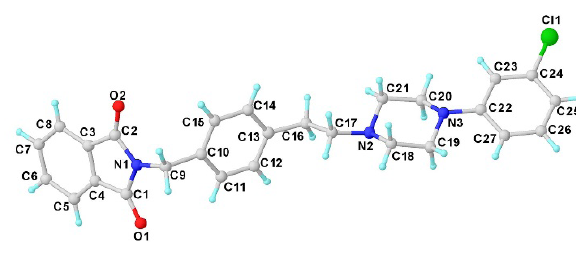
Figure 4: Crystal structure of compound 1 by single-crystal X-ray diffraction.